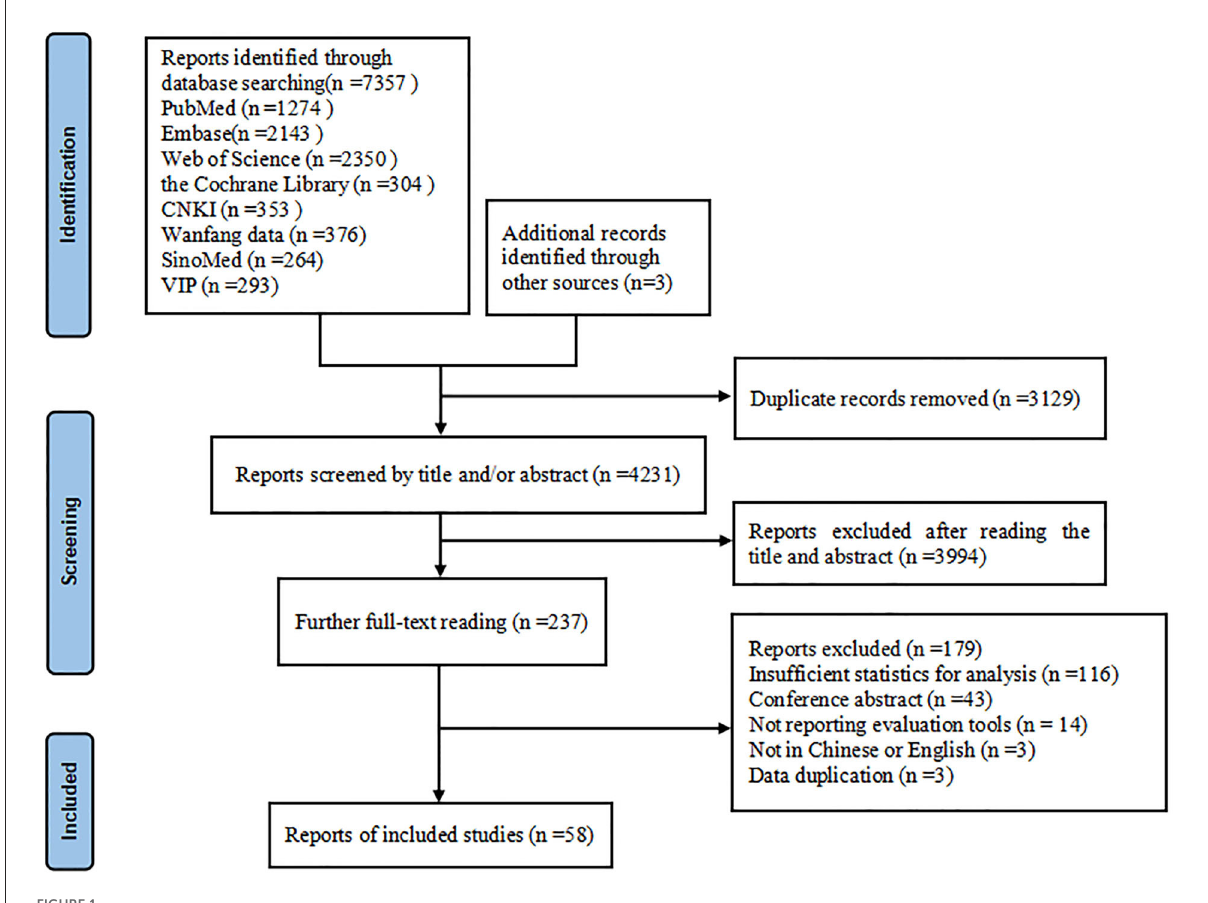
FIGURE1 The specific inclusion screening